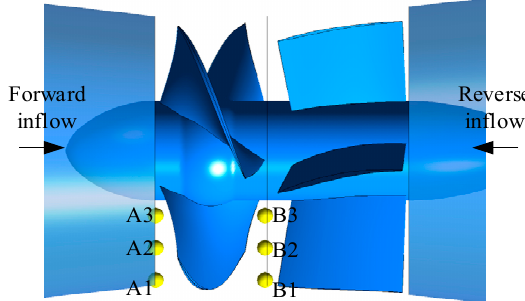
Figure 15. The position of monitoring points.